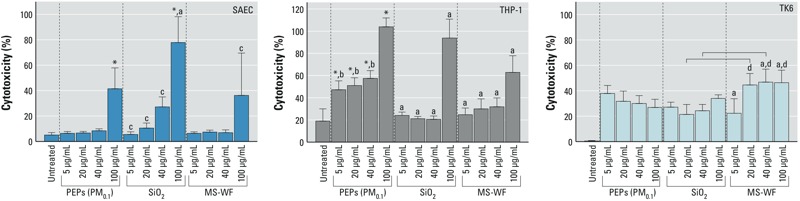
Percent cytotoxicity of cells determined using the LDH assay following exposure to PEPs (PM0.1), SiO2, and MS-WF on three human cell lines (SAEC, small airway epithelial cell; THP-1, monocytic cell line; TK6, lymphoblast cell line). All values are represented as the mean ± SE. *p < 0.05, values significantly different from those for untreated cells: a,PEPs (PM0.1) dose-matched; b, PEPs (PM0.1) 100 μg/mL; c, SiO2 100 μg/mL; d, MS-WF 5 μg/mL treatment groups. Bar represents a significant difference in measurements across the treatment groups with p < 0.05.